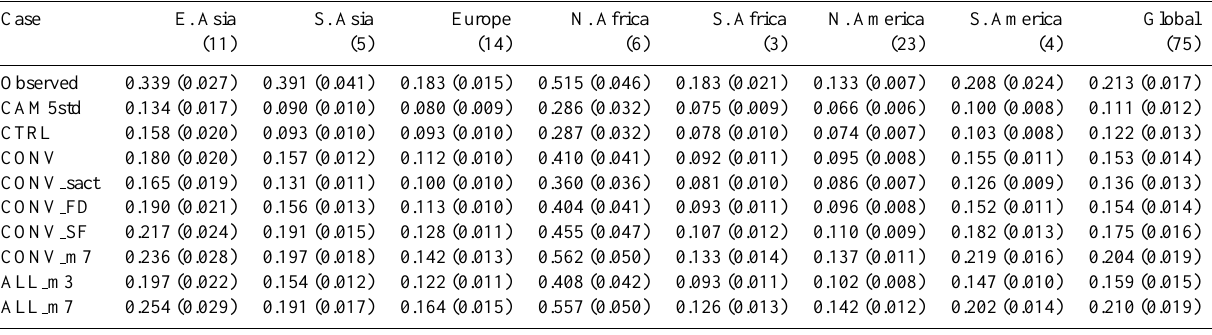
Table 4. Global and regional mean observed and simulated AOD and AAOD (in parentheses). Observed values are from AERONET sites. Number of sites for each region is also in parentheses.